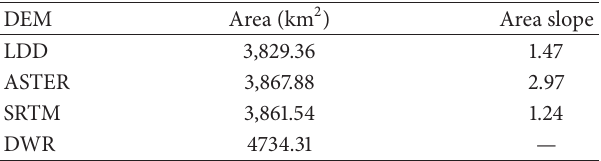
Table 9: Size of area extracted from DEM of Nam-Yang